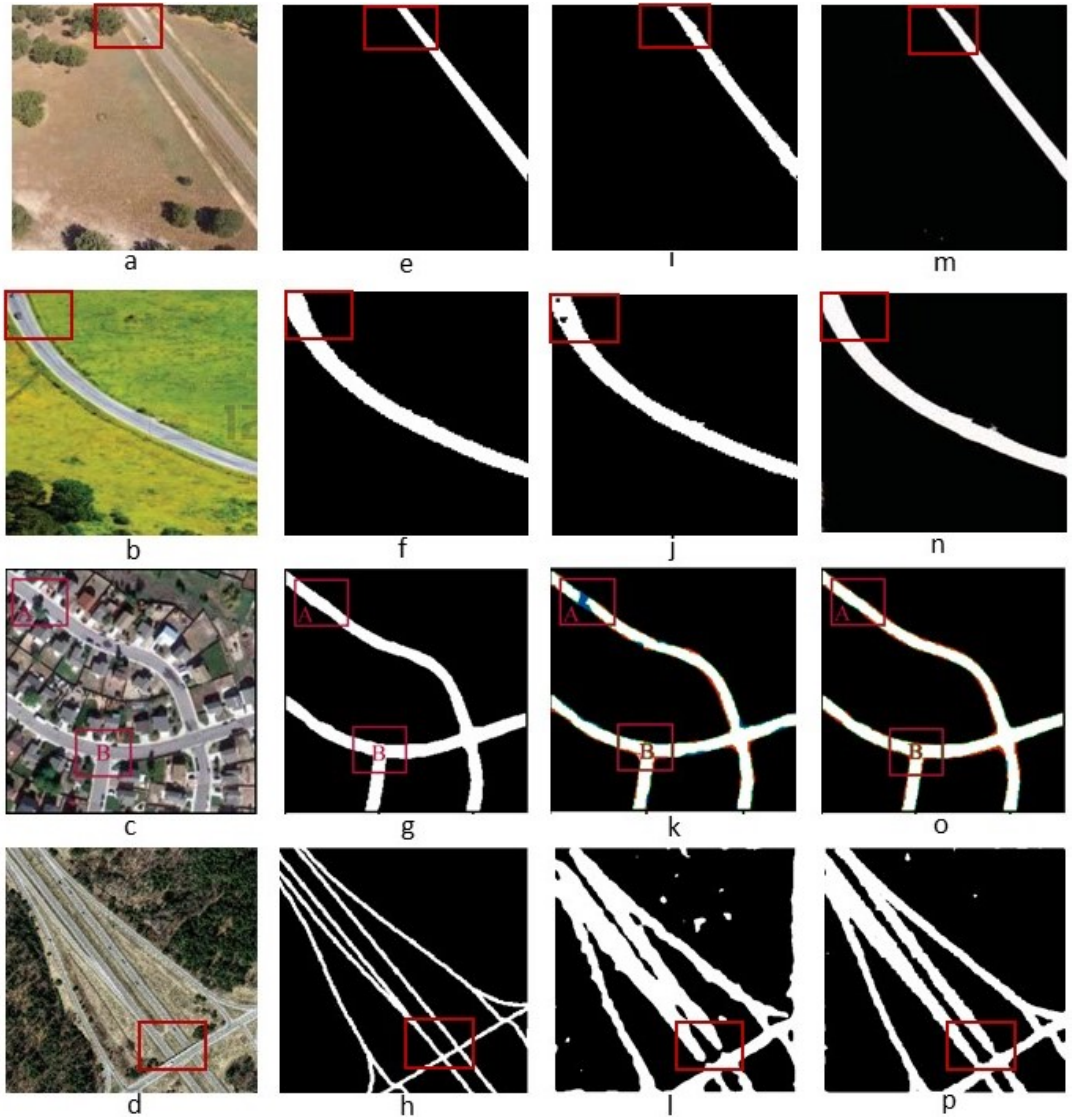
Figure 8. Extracted road parts using deep learning methods from high ‐ resolution remote sensing images: ( a,b,c,d ) original images; ( e,f,g,h ) corresponding reference maps; ( i,j ) results of FCN ‐ 32 and ( k ) result of DeepLab V3+; ( m,n ) results of GANs ‐ UNet and ( o ) result of DenseNet model; and ( l,p ) results of CNN and RSRCNN methods, respectively.